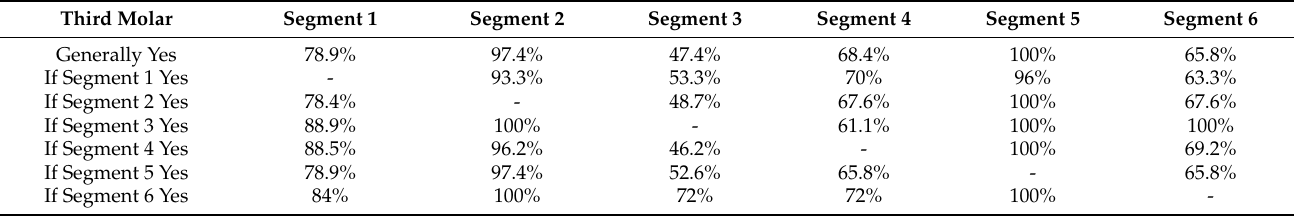
Table 2. Percentage of the IAN’s intraosseous position regardless of the positional relationship of the IAN and third molar at the level of the third molar. In the presence of a hyperintense signal in a specific segment, it is noted whether other segments were simultaneously filled.